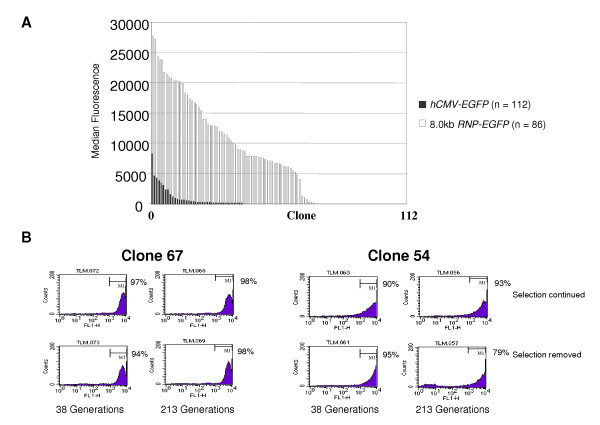
The 8.0 kb RNP CpG island fragment gives a high proportion of clonal CHO-K1 cell lines showing high-level, stable expression of EGFP. Following stable transfection of CHO-K1 cells clonal lines were derived by limiting dilution. Median fluorescence levels were measured for each clone by FACScan analysis after 22 generations of culturing with drug selection. A. Histograms representing the median fluorescence levels for clones generated with hCMV-EGFP (n = 112) and 8.0 kb RNP-EGFP (n = 86). B. FACscan analysis of two clonal lines described in A. Clonal cell lines were subcultured continuously with or without drug selection for a further 213 generations, with analysis after 38 and 213 generations. Figures for gate M1 are % cells showing greater than 1000 fluorescence units.